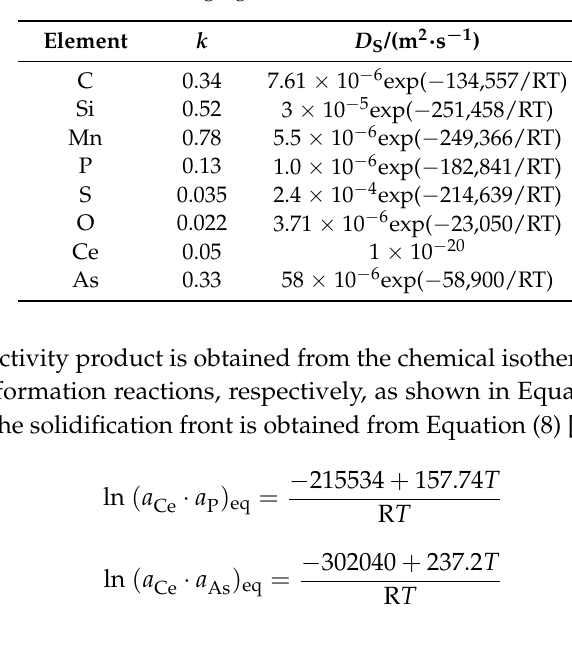
Table 6. Segregation constants